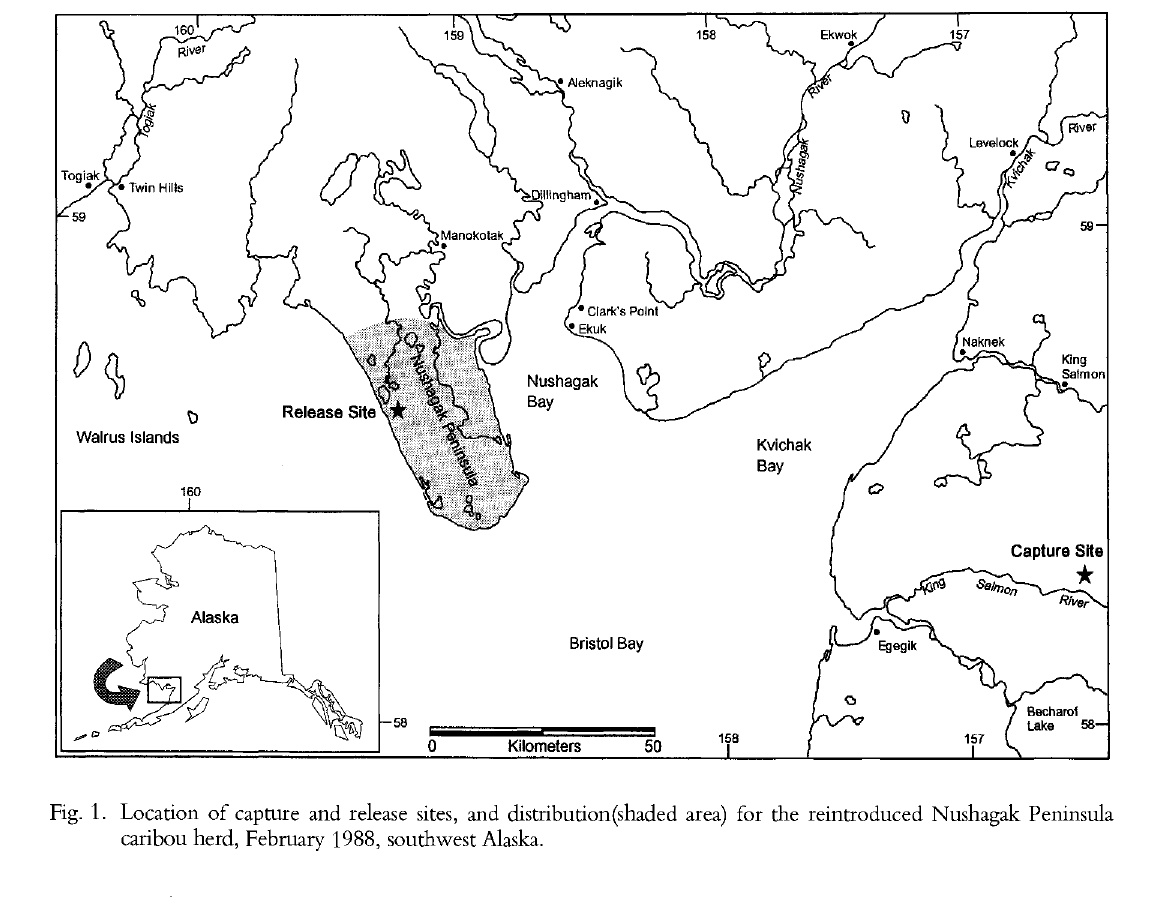
Fig. 1. Location of capture and release sites, and distribution(shaded area) for the reintroduced Nushagak Peninsula caribou herd, February 1988, southwest